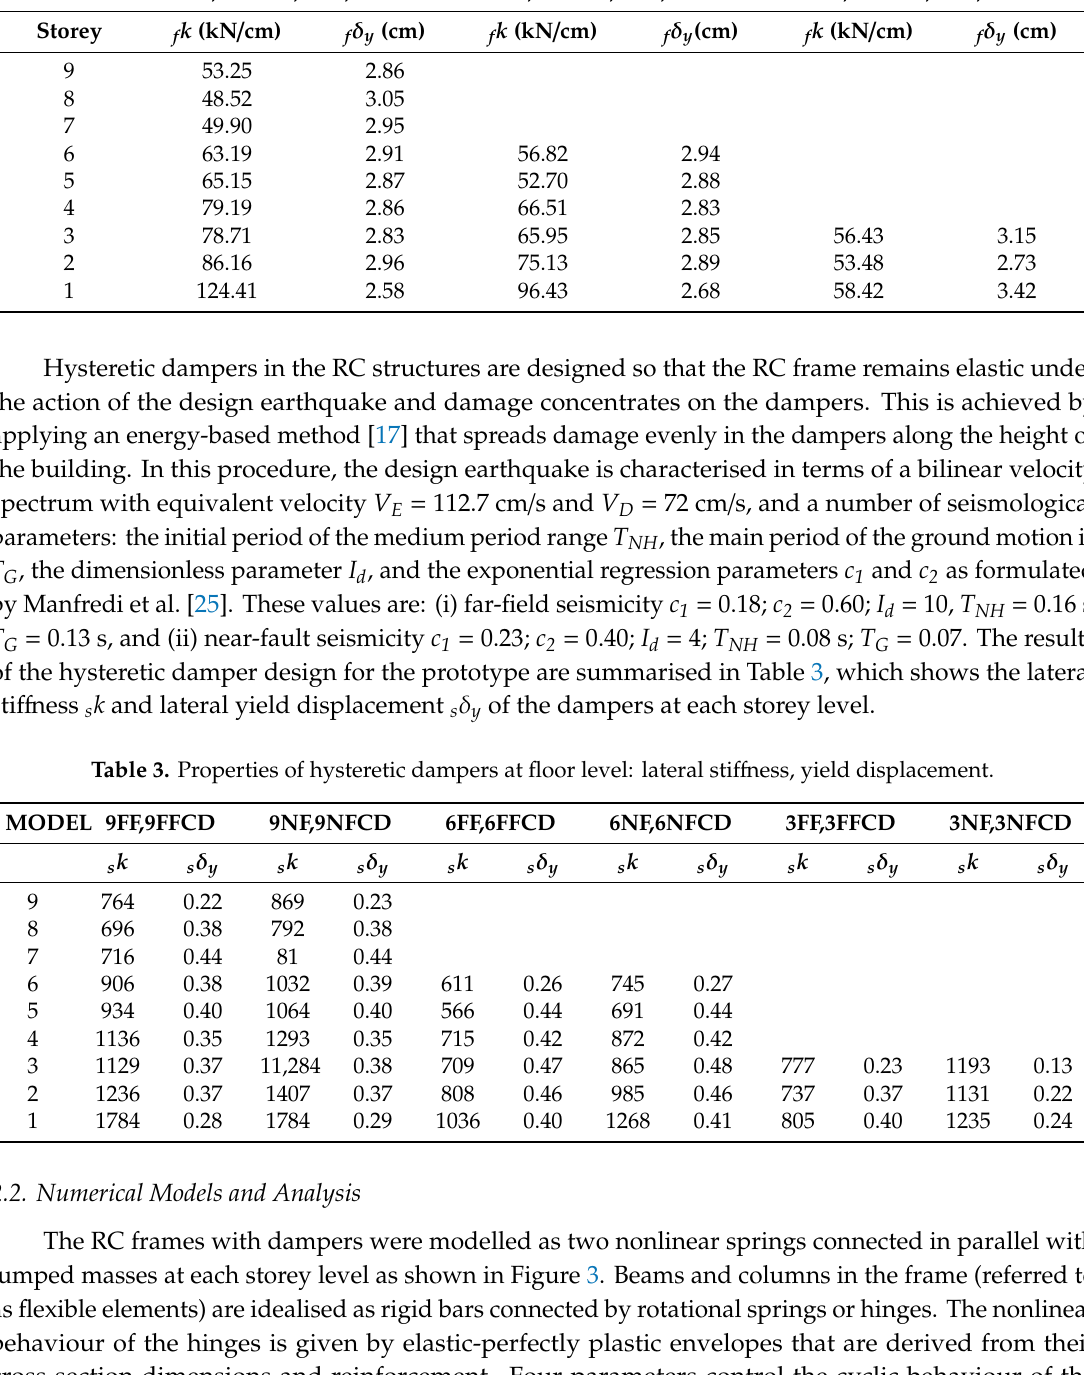
Table 2. Properties of reinforced concrete (RC) frames at floor level: lateral sti ff ness, yield displacement. MODEL